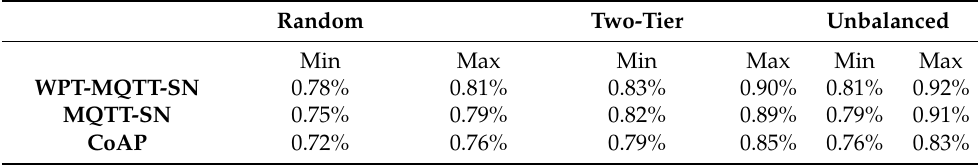
Table 3. Normalised residual energy comparisons for different topologies and protocols. Random